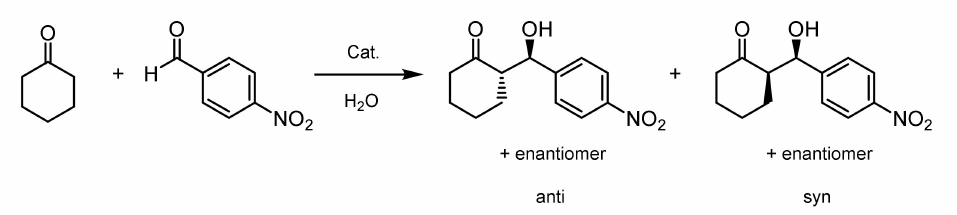
Figure 7. Aldol reaction between p -NBA and CH catalyzed by the thermoresponsive block copolymers carrying the L-prolineamide-based organocatalyst. Table 5. Data for the organocatalytic aldol reaction of CH and p -NBA after 24 h reaction time, using the thermoresponsive block copolymers carrying the L-prolineamide-based organocatalyst.